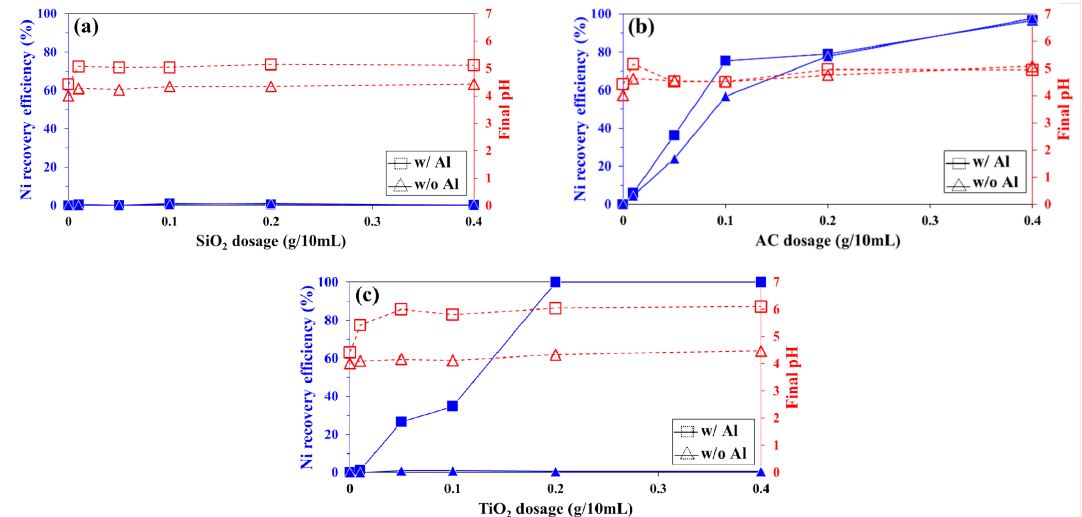
Figure 5. The effects of ( a ) SiO 2 , ( b ) AC, and ( c ) TiO 2 dosages on the recovery efficiency of Ni 2+ and final pH in chloride solutions at initial pH 4.0 for 24